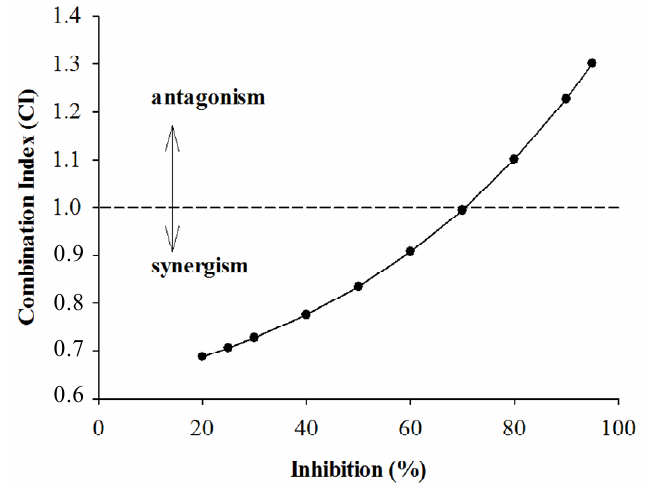
Figure 3. The CI of interaction between EGCG and acarbose on α